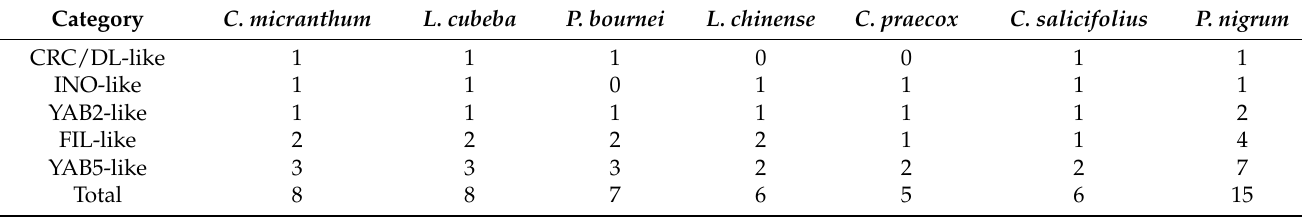
Table 1. The classification of the YABBY gene family in Cinnamomum micranthum, Litsea cubeba, Phoebe bournei, Liriodendron chinense, Calycanthaceae praecox, Calycanthaceae salicifolius, and P. nigrum .